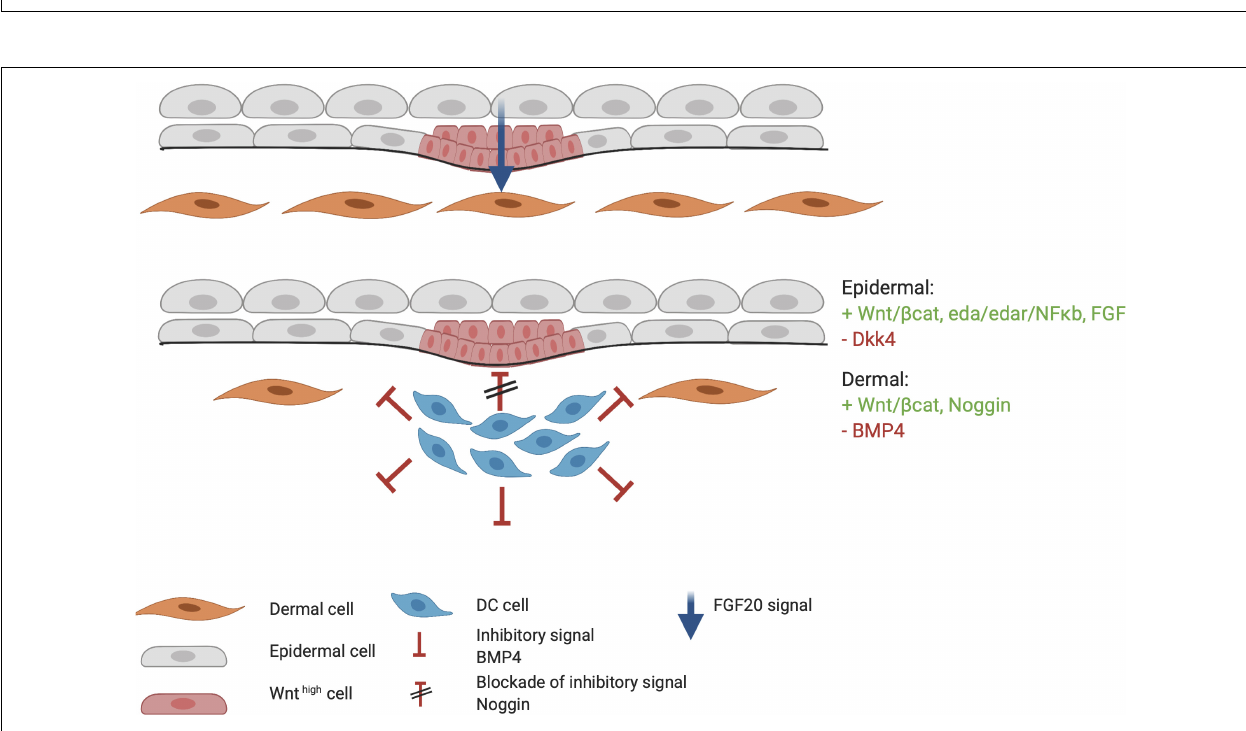
FIGURE 4 | Formation of the dermal condensate (DC). FGF20 is the first epidermal signal that marks the start of the organogenesis phase. FGF20 induces DC formation in the dermis. DC cells produce inhibitory factors such as BMP4 to fine tune the borders and specification of the DC. At the apical side of the DC, high concentrations of Noggin block the inhibitory signaling of BMP4. Meanwhile, the placode continues to mature through the FGF, WNT/ β -catenin, and EDA/EDAR/NF- κ B axis. Red indicates inhibitory signaling, and green indicates stimulatory signaling.